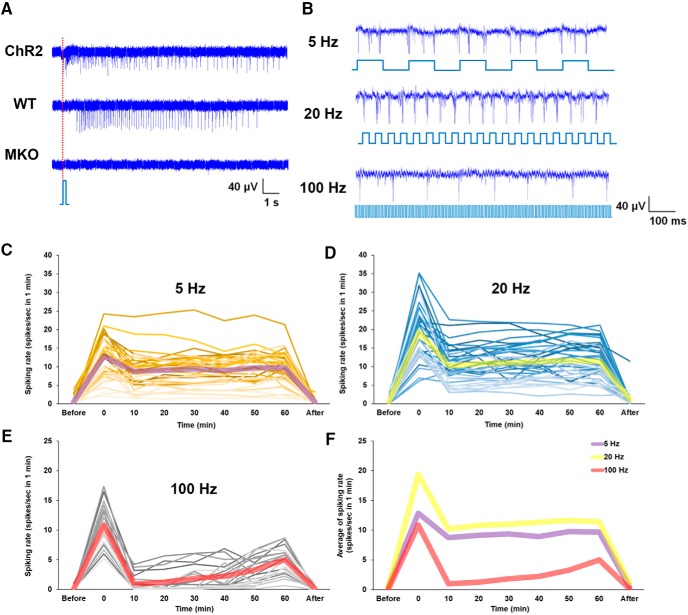
MEA recording of P11 retinas with ChR2-expressed RGCs in response to blue light stimulation. A, Responses of the RGCs from the three different strains of mice (ChR2, WT, and MKO) on a 200-ms blue light stimulation. The dotted line represents the start of light stimulation. B, Responses of the RGCs from ChR2 mice on 5, 20, and 100 Hz continuous blue light stimulation. When the retina was activated by 5 and 20 Hz blue light, the recorded RGC showed phase-locking responses. However, the same RGC, when stimulated by 100 Hz blue light, was not able to elicit reliable spiking responses after each light stimulation. C–E, the spiking rates of the RGCs from ChR2 mouse retinas in response to 5 Hz (n = 35), 20 Hz (n = 37), and 100 Hz (n = 20) blue light stimulation continuously for 1 h. The spiking rate of individual RGCs at each time point was based on a 1 min measurement every 10 min. The thick semitransparent lines represent the average spiking rates. F, Comparison of the average responses of the RGCs on blue light stimulation using the three temporal patterns. The RGCs responses at 5 and 20 Hz blue light were relatively sustained throughout the 1-h stimulation, while the 100 Hz blue light evoked mostly only transient responses.